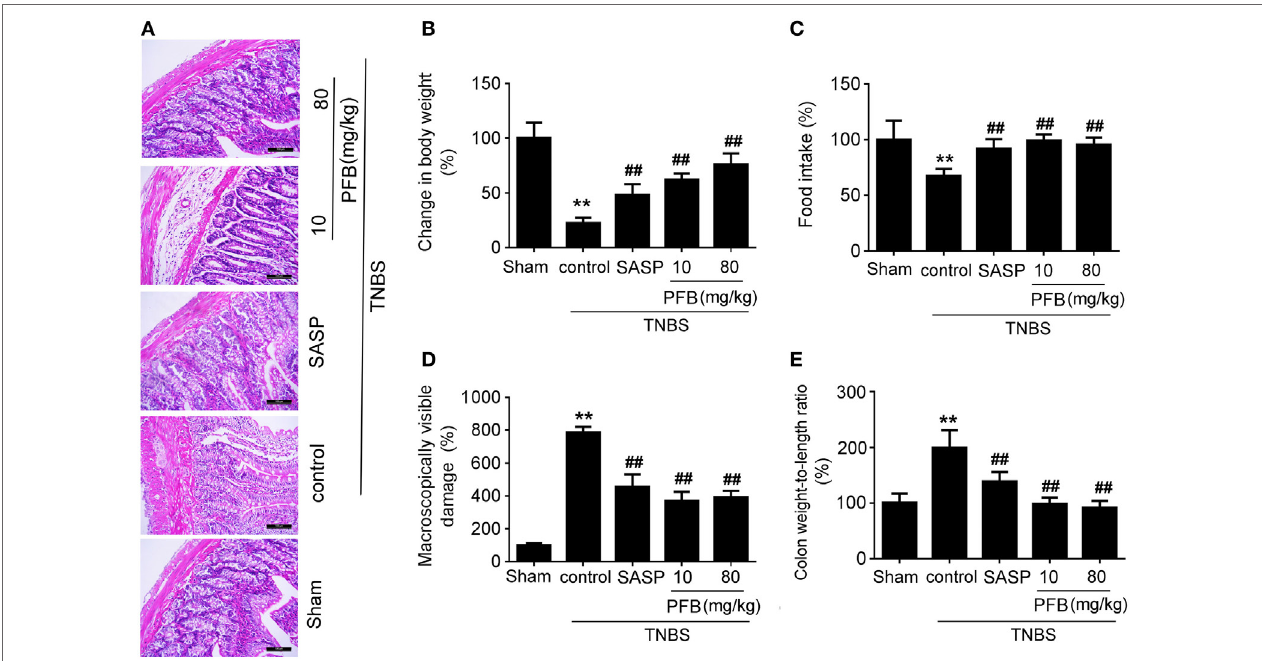
FigUre 2 | Purified fruit bromelain (PFB) alleviated colitis symptoms. Colitis symptoms were examined after 14 days of PFB therapy. (a) Hematoxylin and eosin -staining of rat colonic tissue (20 × , scale bar is 100 µm). Effects of PFB on (B) body weight, (c) food intake, (D) macroscopically visible damage, and (e) colon weight-to-length ratio in colitis rats. Data in the sham group are set to a relative value of 100% and expressed as the mean ± SD. Other data are the relative values compared with sham: ** P < 0.01 compared with sham group ( n = 6 rats); ## P < 0.01 compared with TNBS control group ( n = 6 rats). SASP, sulfasalazine.